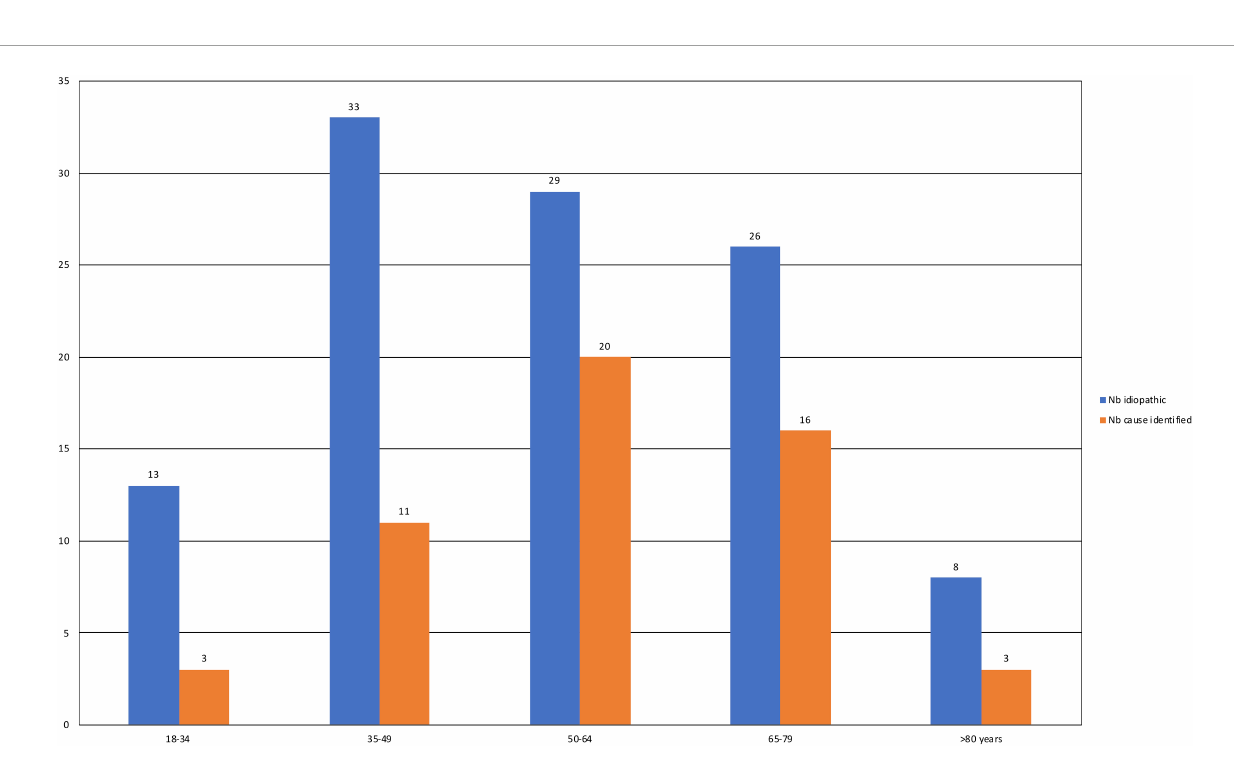
FIGURE2 Numbers of patients by age group for those with idiopathic SFN and SFN with an identified cause. The chi2 test was used for comparisons between the two